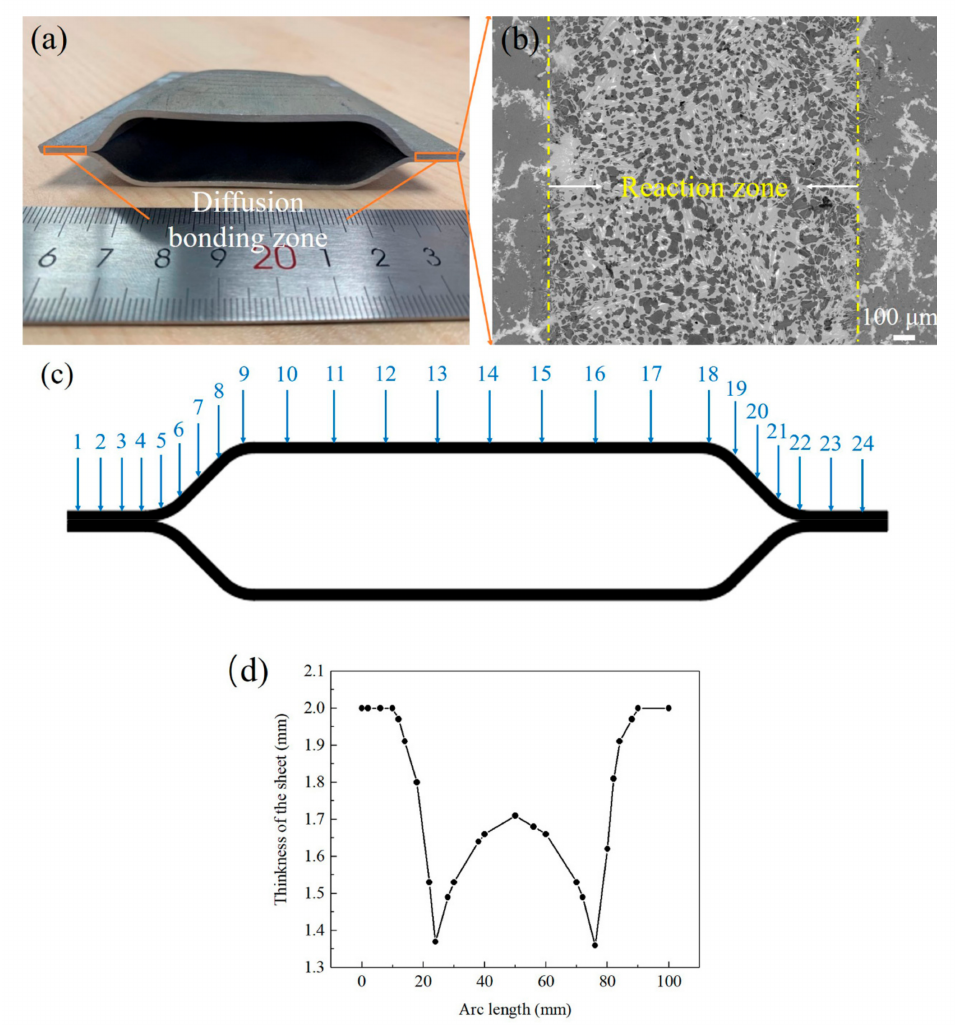
Figure 17. ( a ) The cross-section of the finished double hollow structural component; ( b ) microstruc- ture of the diffusion bonding zone; ( c ) the position of thickness measurement; ( d ) The thickness distribution of the